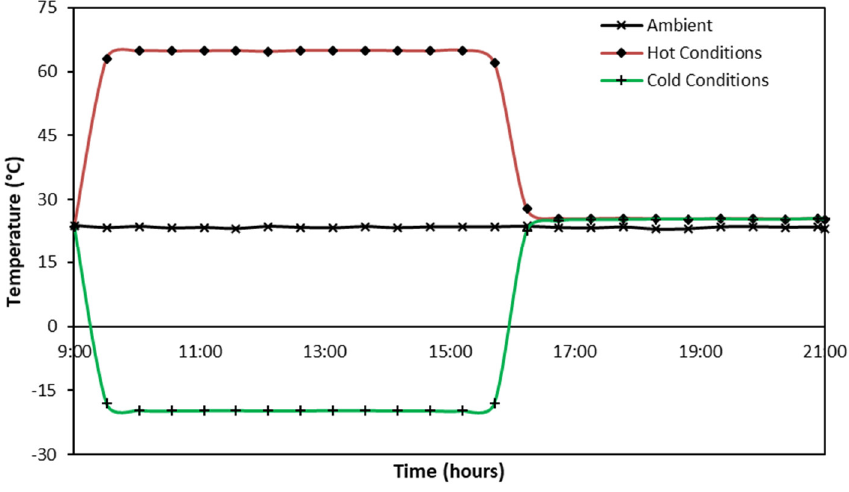
Figure 2. Temperature profile applied for all samples.